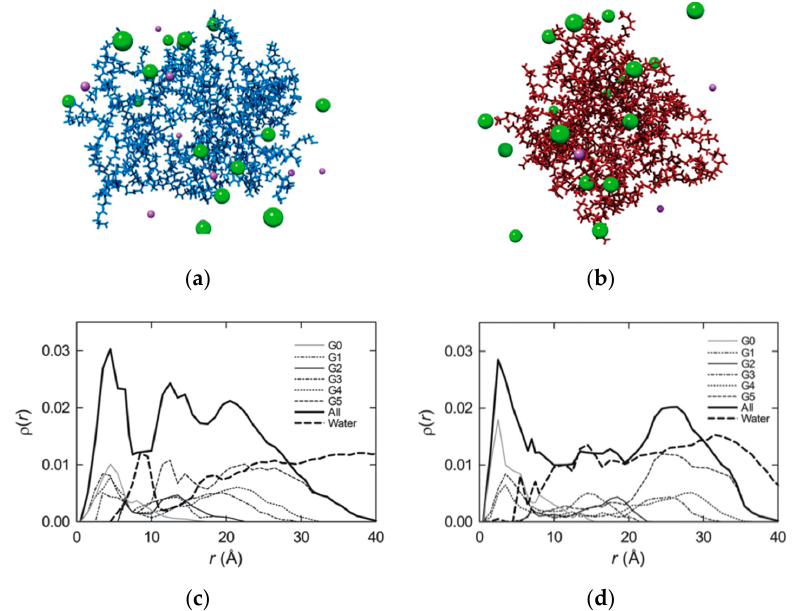
Figure 2. Equilibrated molecular dynamics conformations of G 5 TEA-core ( a ) and NH 3 -core ( b ) poly(amidoamine) (PAMAM) dendrimers in physiological solution (pH = 7.4, ionic strength = 0.15 M NaCl). Each dendrimer molecule is represented as colored sticks, some ions and counterions are visualized as purple (Na + ) and green (Cl − ) spheres, and water molecules are not shown for clarity. Average radial monomer density ρ (r) for subsequent generations (from G 0 to G 5 ) of the TEA-core ( c ) and the NH 3 -core PAMAMs ( d ). In all cases, the origin was set at the molecular center of mass. Adapted from [37], published by RSC, 2013.